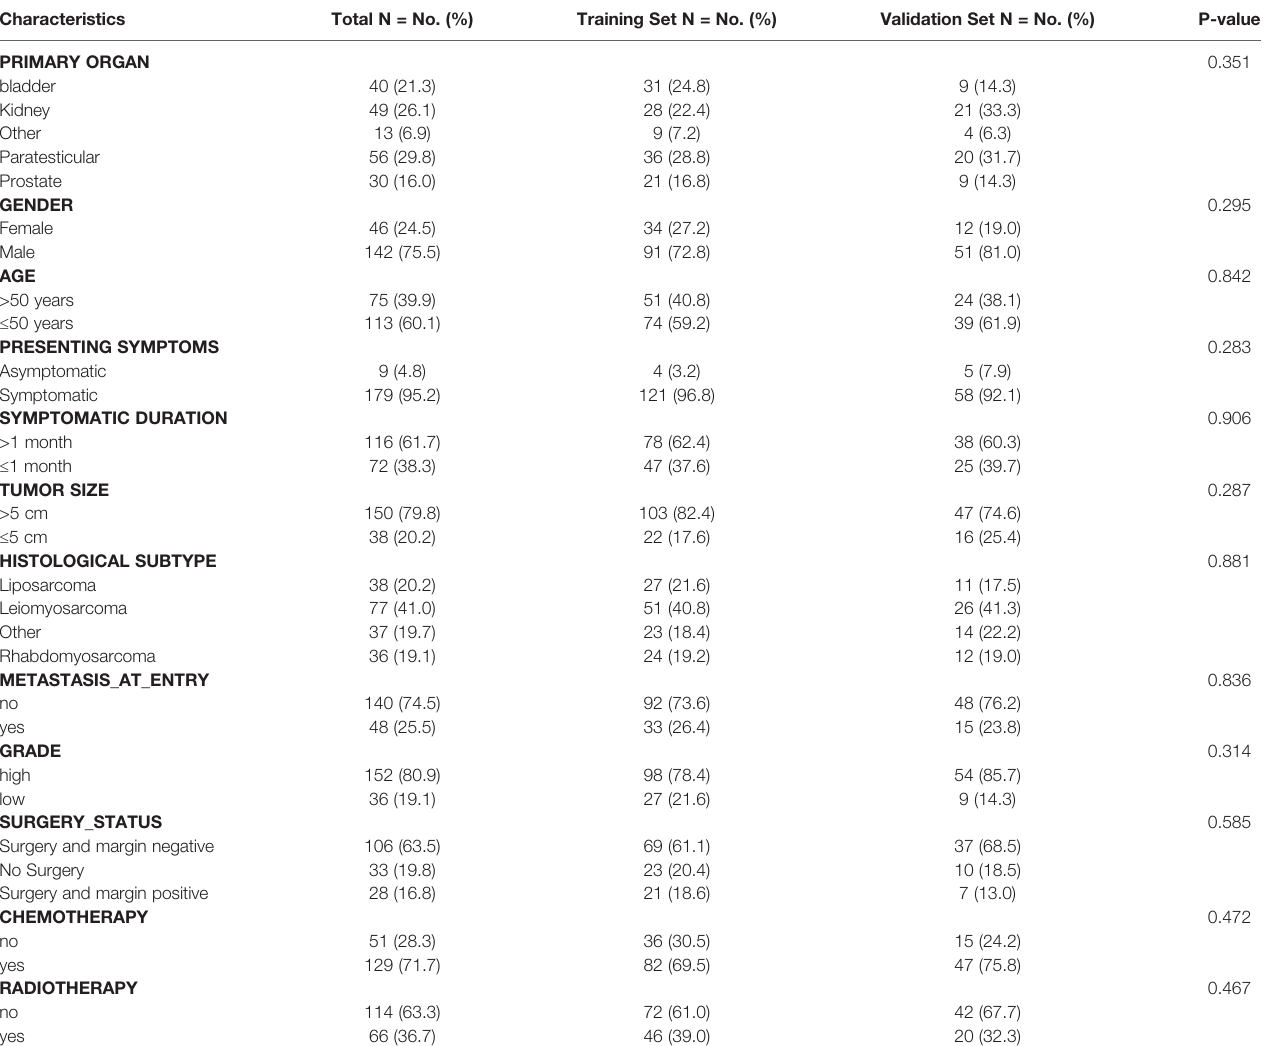
TABLE 4 | Clinical characteristic of patients in training set and validation set.